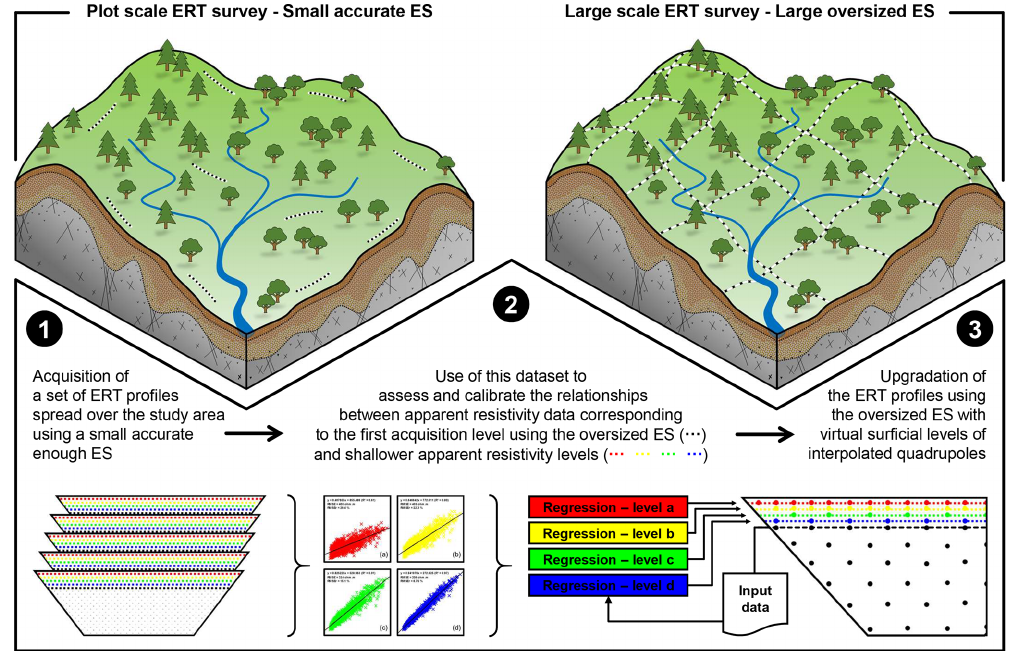
Figure 4. Proposed approach to upgrade ERT datasets relying on a large oversized ES by adding interpolated levels of surficial apparent resistivity based on a limited number of measurements with a small accurate